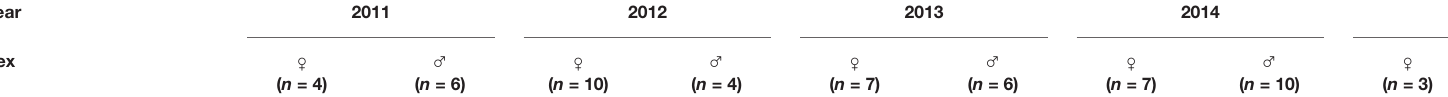
) and male ( ) sooty terns that had ♀ ♂